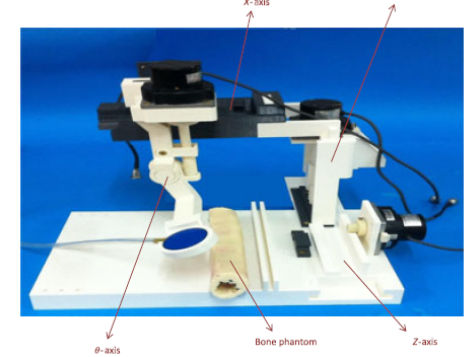
Figure 13. MRI-guided focused ultrasound robotic system developed by Menikou et al. for HIFU treatment of small animals [66].